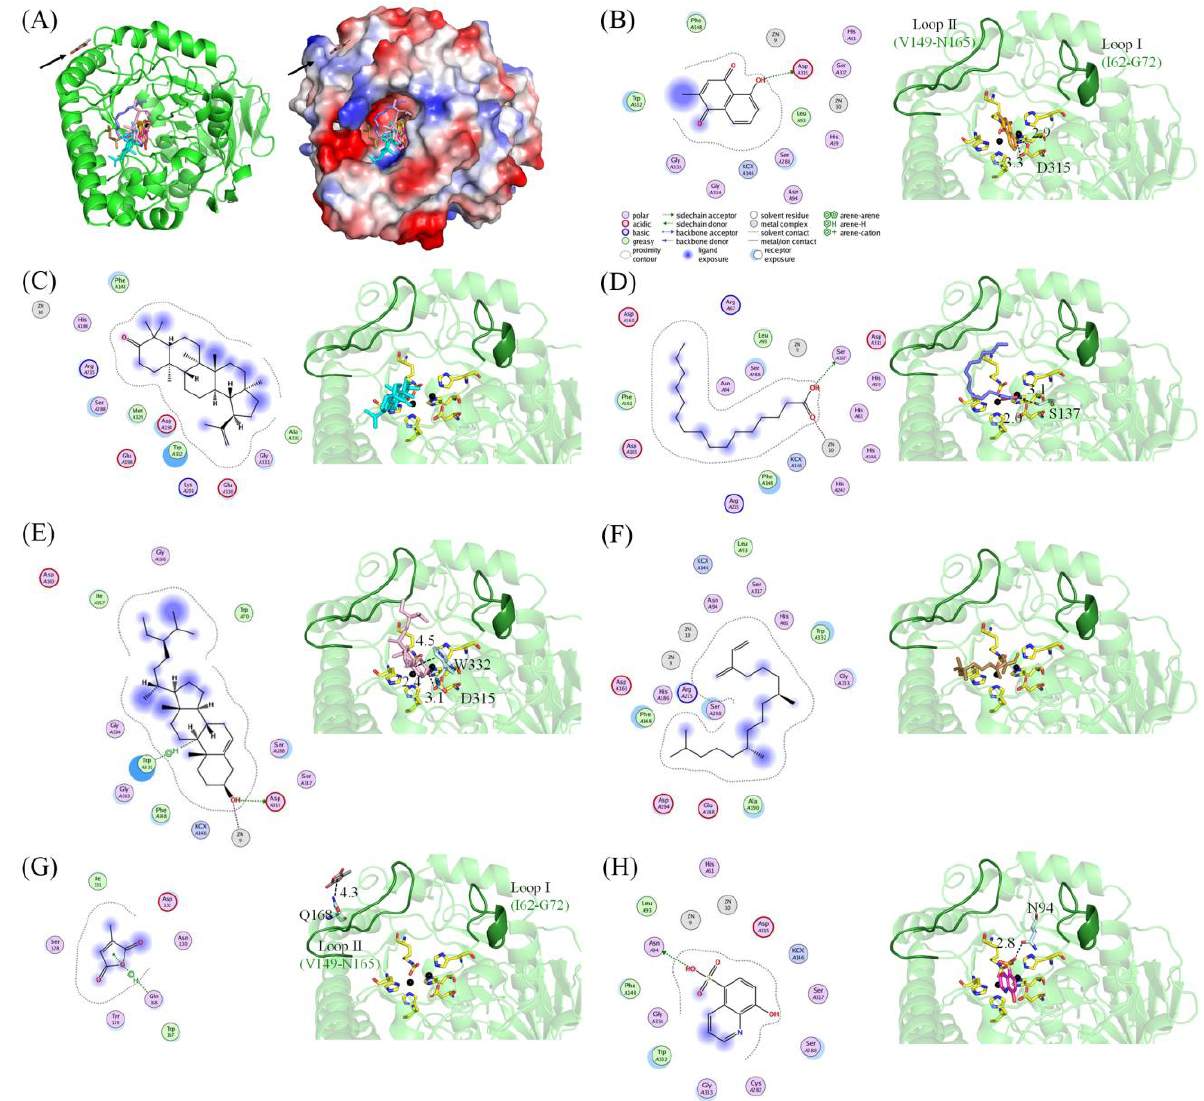
Figure 5. Molecular docking. ( A ) Docking results. Plumbagin, lupenone, palmitic acid, stigmast-5- en-3-ol, neophytadiene, citraconic anhydride, and 8-HQSA were docked to EcALLase-BL21 (PDB ID 8HFD) via the MOE-Dock tool. The superimposed structures of these EcALLase-BL21 complexes based on docking experiments are shown. As indicated, only citraconic anhydride could not be docked into the active site of EcALLase-BL21. The binding mode of ( B ) plumbagin, ( C ) lupenone, ( D ) palmitic acid, ( E ) stigmast-5-en-3-ol, ( F ) neophytadiene, ( G ) citraconic anhydride, and ( H ) 8- HQSA to EcALLase-BL21 is shown.